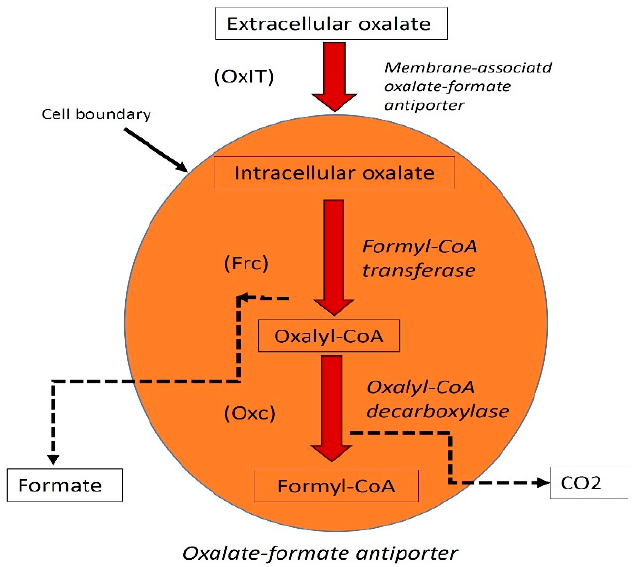
Figure 3. Oxalate degradation pathway in O. formigenes . Enzyme names are italicized with their protein abbreviations in brackets; dotted lines show secreted product